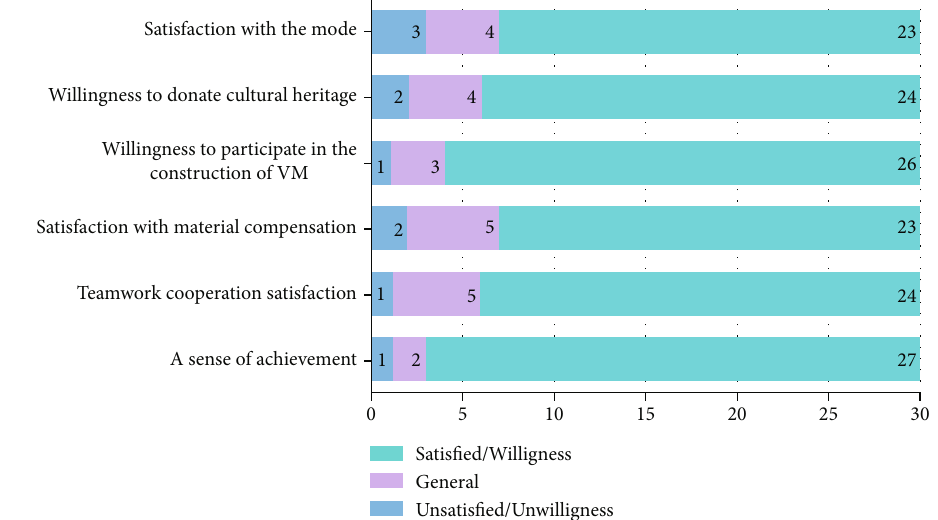
Figure 5: Villagers ’ feeling, satisfaction, and willingness of participating in the Mt. Mogan virtual museum.